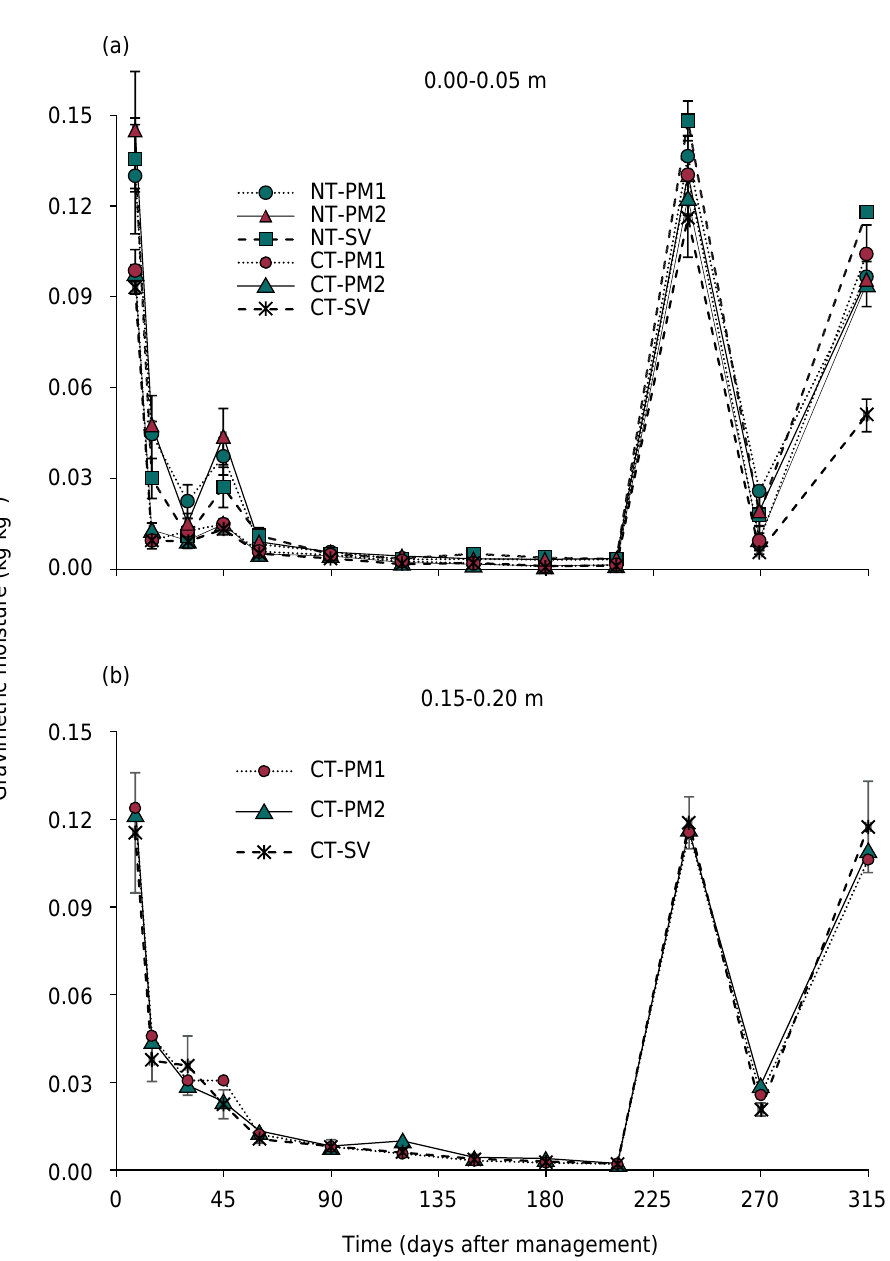
Figure 3. Gravimetric moisture in the 0.00-0.05 and 0.15-0.20 m layers of a Argissolo Vermelho Amarelo (Ultisol) under two soil tillage systems (NT = no tillage; CT = conventional tillage) and after management of three mixtures of cover crops in mango interrows (PM1 = 75 % leguminous species + 25 % grass and oilseed species; PM2 = 25 % leguminous species + 75 % grass and oilseed species; and SV = spontaneous vegetation). Bars represent the standard error of the